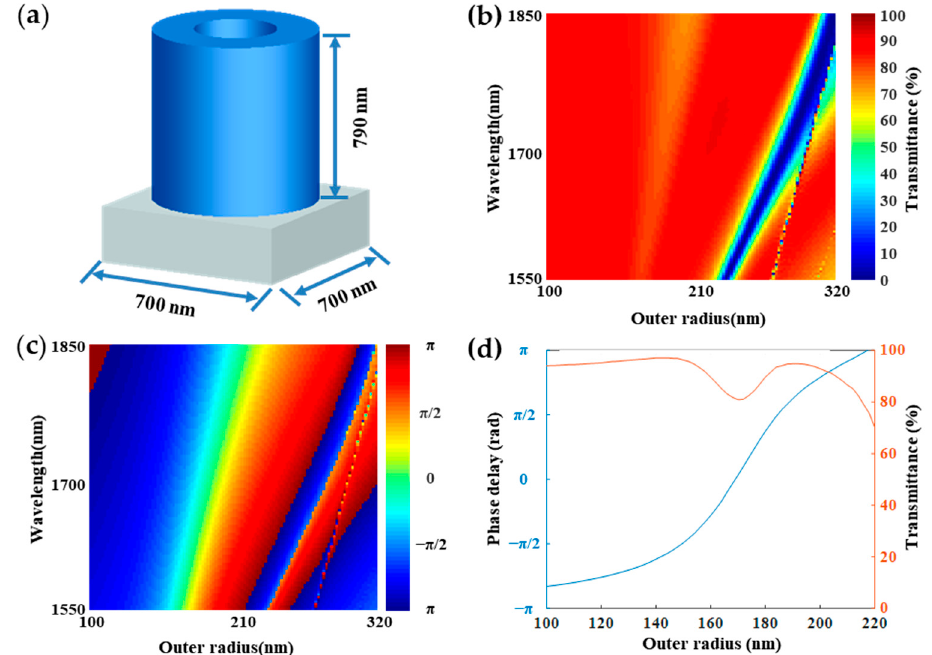
Figure 2. The properties of the beam splitter. ( a ) the element structure of the designed beam splitter based on a gradient metasurface; ( b ) the transmittance intensity of the nano-ring arrays in the infrared region; ( c ) the phase delay of the transmitted beam in the infrared region; ( d ) the resulting phase delay and transmittance of beam with different outer radius R out at the wavelength of 1550 nm.